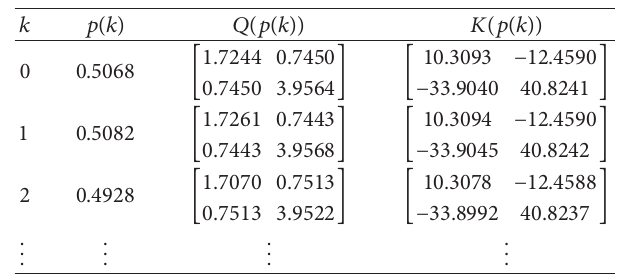
Table 1: Computing